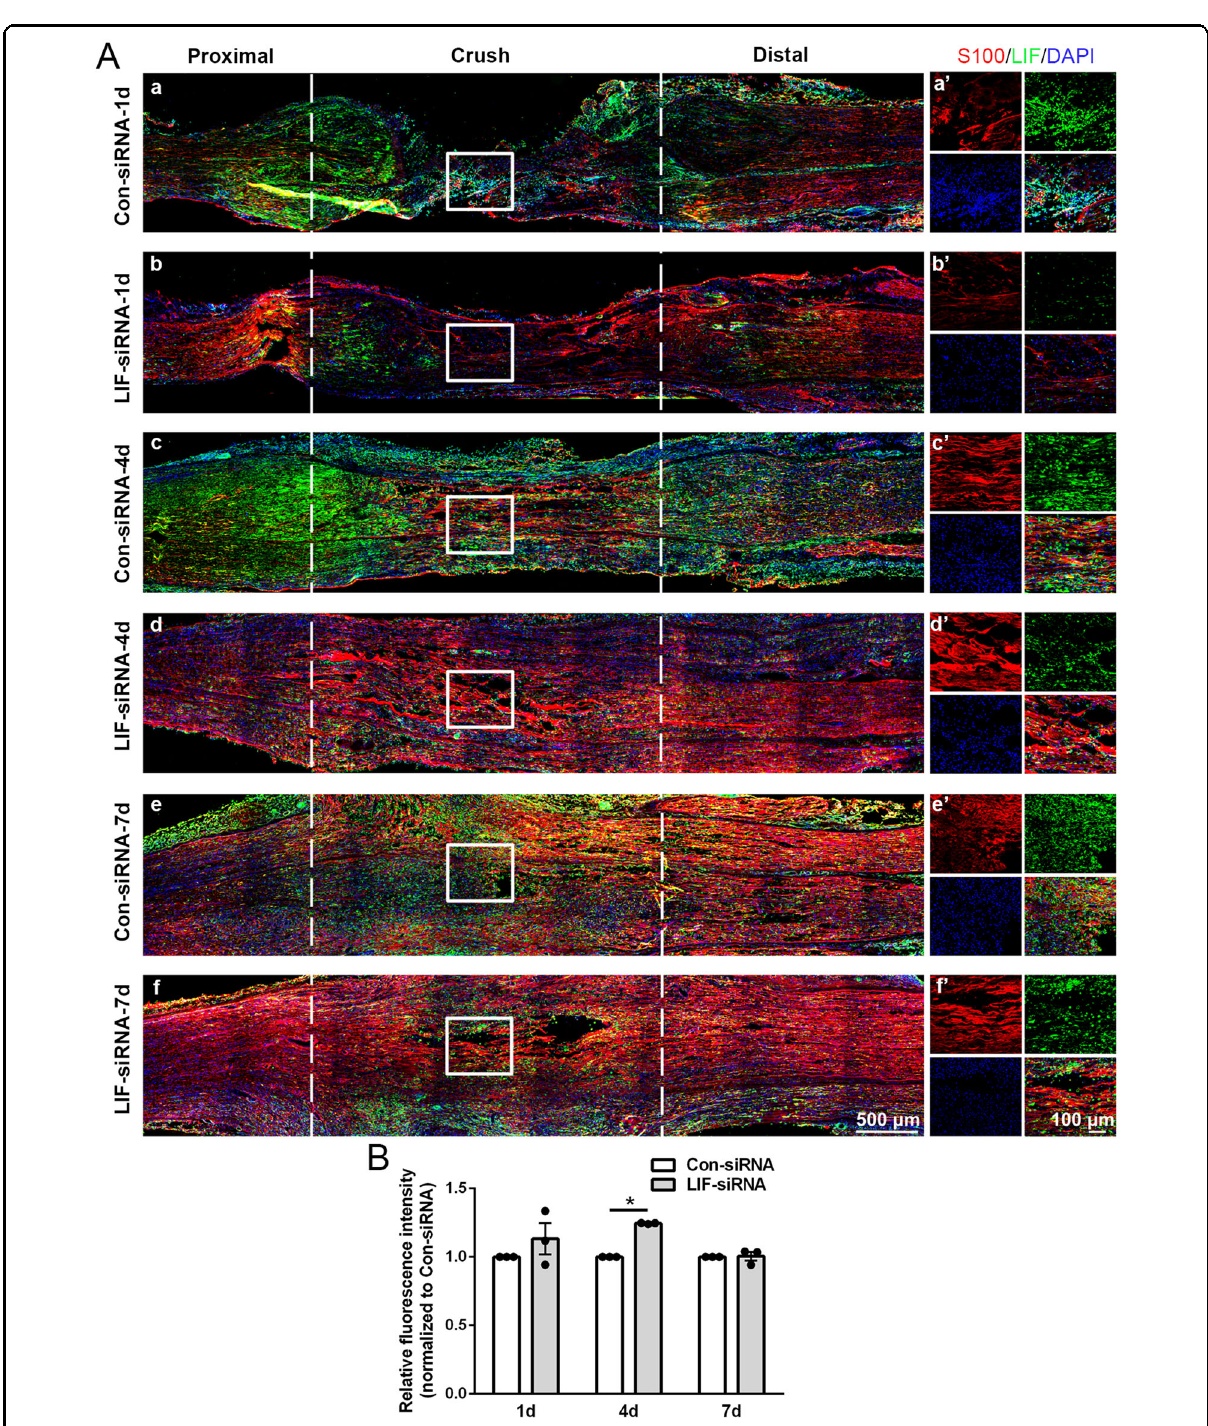
Fig. 3 LIF-siRNA promotes Schwann cell migration in vivo. A Representative immunostaining images of sciatic nerve longitude sections of rats injected with control-siRNA or LIF-siRNA. Rat sciatic nerve segments are collected at (a and b) 1 day, (c and d) 4 days, and (e and f) 7 days after nerve crush injury. Injured areas (proximal segments, crush sites, and distal segments) are labeled with dashed lines. Green color indicates LIF, red color indicates S100 β , and blue color indicates nucleus. Boxed areas are demonstrated at a higher magni fi cation on the right. Scale bars indicate 500 μ m in main images and 100 μ m in magni fi ed images. B Quanti fi cation of the relative fl uorescence intensity of S100 β at the middle of the injured site in rats injected with control-siRNA or LIF-siRNA at 1 day, 4 days, and 7 days after nerve crush injury. Data were presented as means ± SEM. * p value <0.05 versus control-siRNA